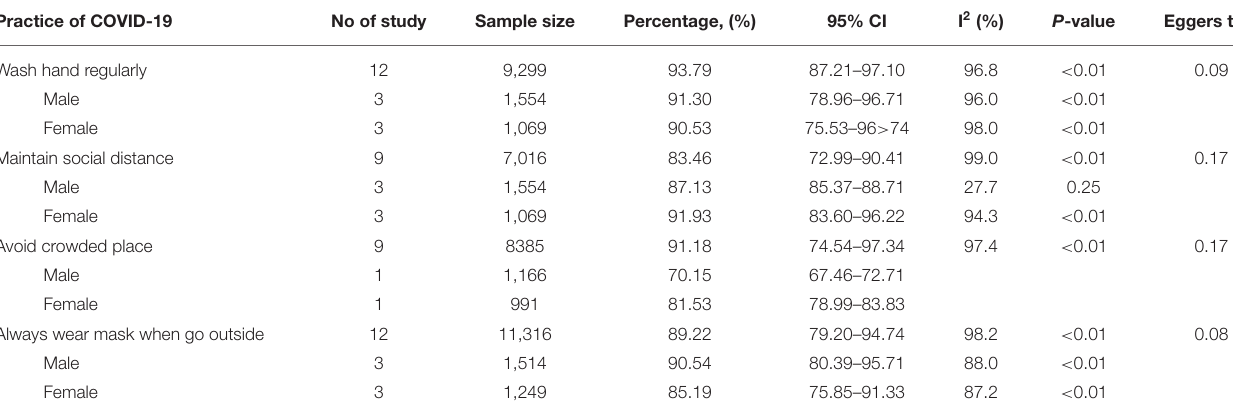
TABLE 4 | Pooled prevalence of practice about COVID-19 among Bangladeshi residents. Practice of